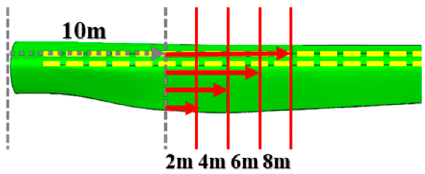
Figure 7. Debonding damage length (shown for 10 m start location). Table 3. Debonding damage map.